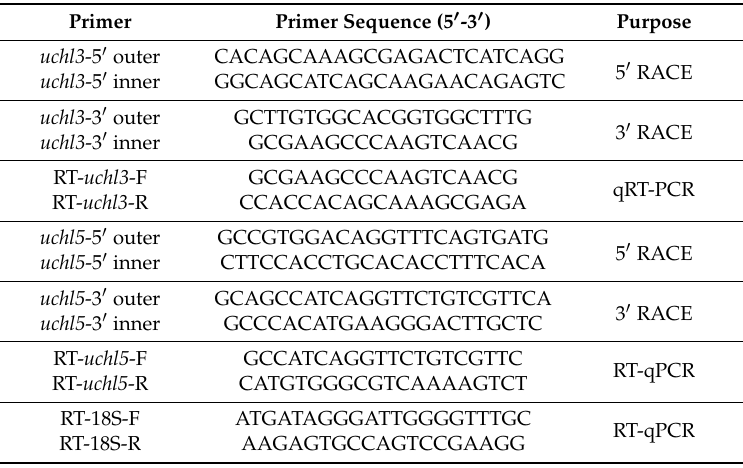
Table 1. Oligonucleotide primers used in this